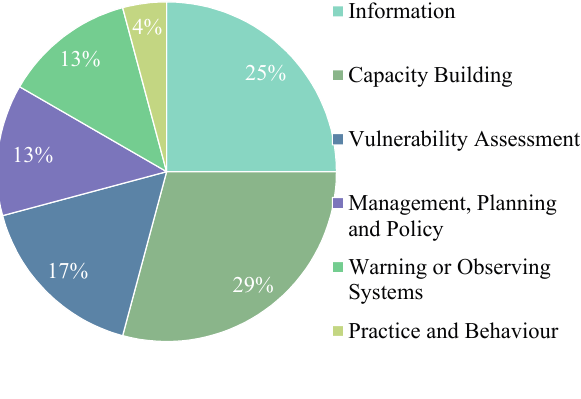
Figure 2. Percentage of federal health adaptation initiatives by adaptation type.